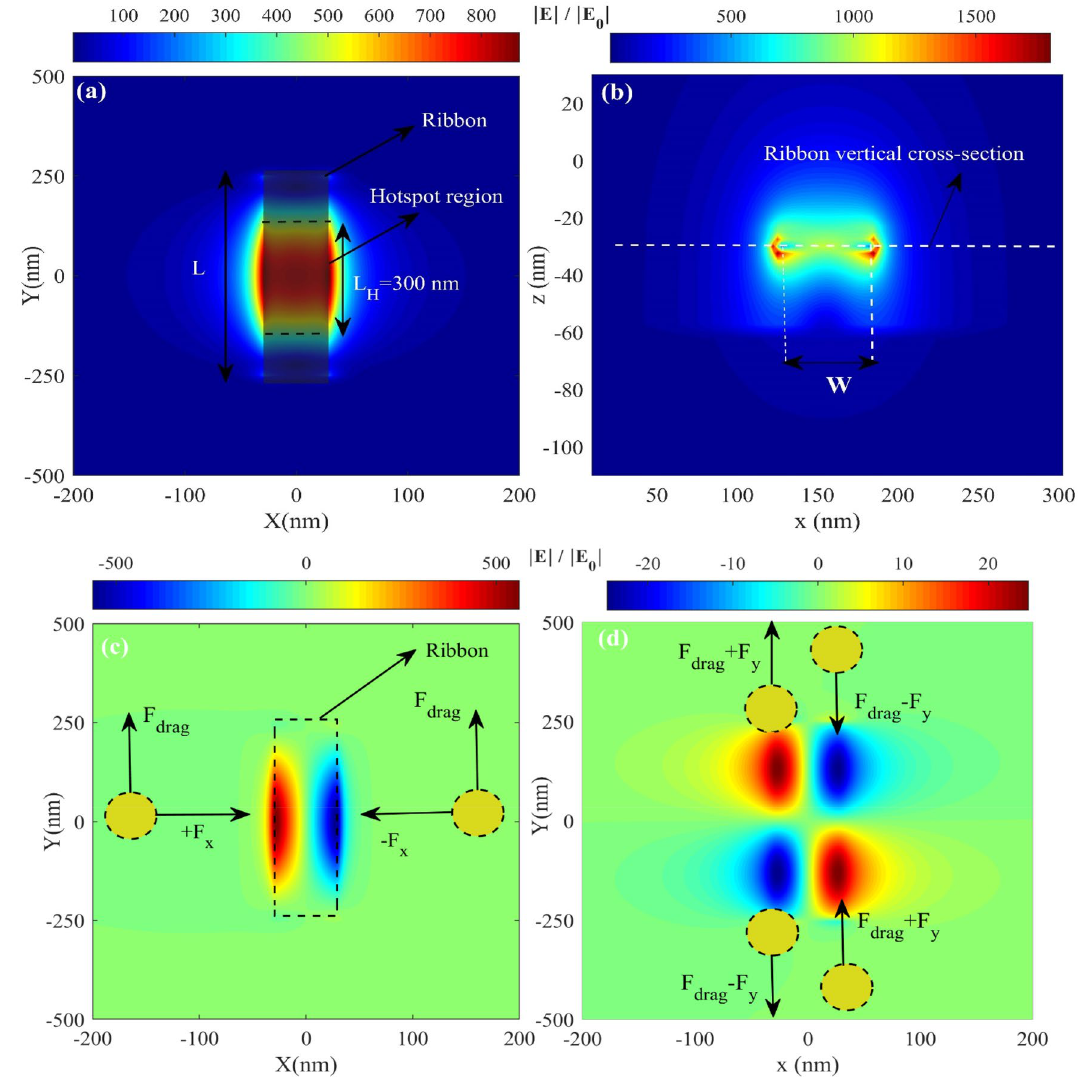
Figure 6. Represents the total component of the electric field at the top view ( a ), the cross-section view of the total electric field ( b ), the x component of the electric field from the top view ( c ), and the y component of the electric field from the top view ( d